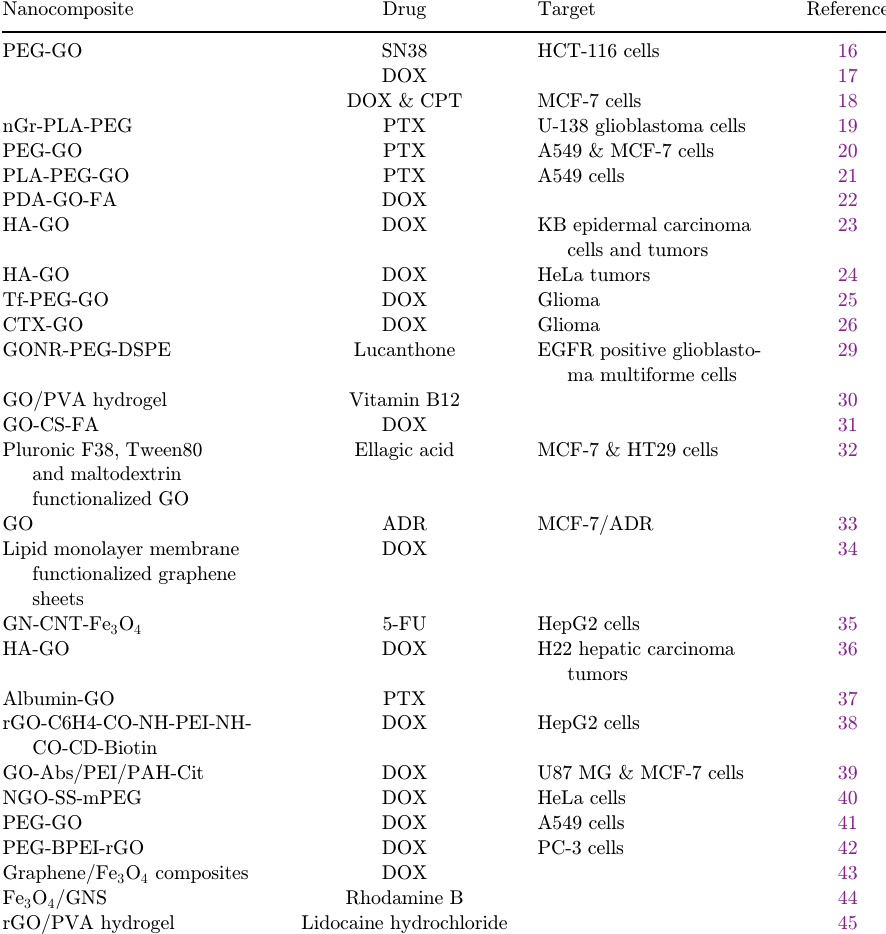
Table 1. Summary of graphene-based nanomaterials for drug